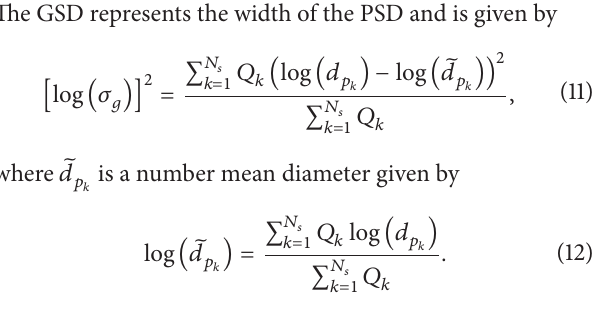
of the 𝑧 -direction averaged particle number concentrations of monomers, 1 nm and 2 nm particles at 𝑡